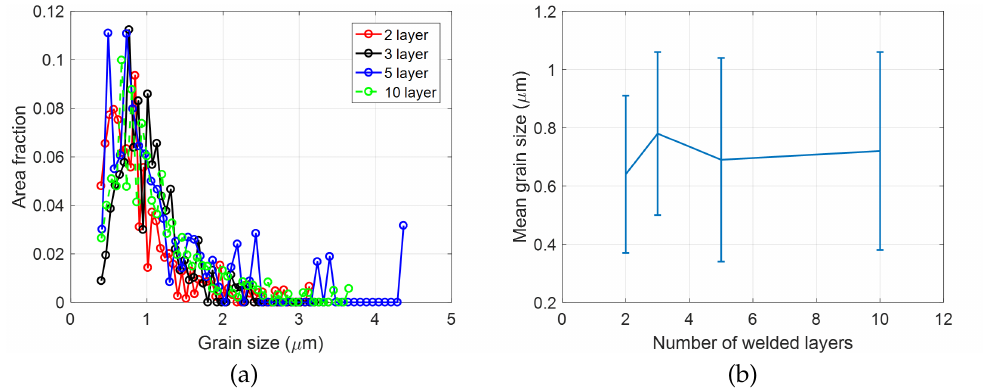
Figure 8. Analysis of the size distribution of grains in the 2-, 3-, 5-, and 10-layer samples: ( a ) histogram of the area of the grains vs. the grain size near the weld interface; ( b ) mean grain size near the foil 1- foil 2 weld interface plotted vs. the total number of layers welded.